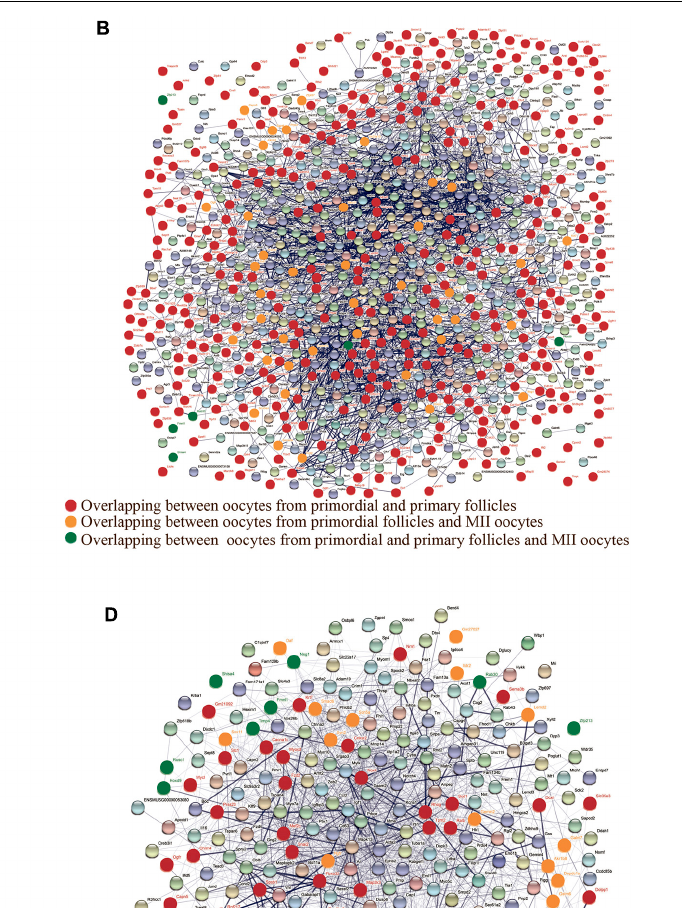
upregulated in oocytes from primary follicles ( Figure 6B